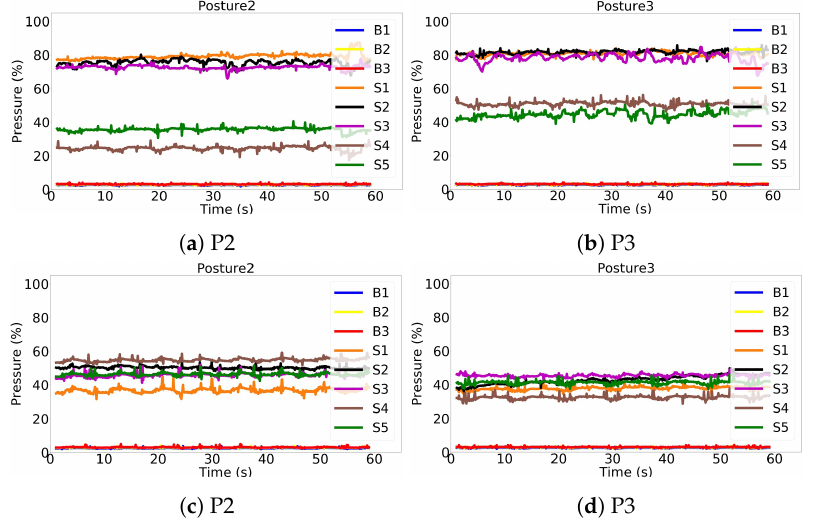
Figure 17. Posture 2 and Posture 3 of different subjects can have similar patterns: ( a , c ) are pressure sensors raw signals of two different subjects while sitting in Posture 2. They are similar to ( b , d ), respectively, which are pressure sensors raw signals of other two subjects while sitting in Posture 3.